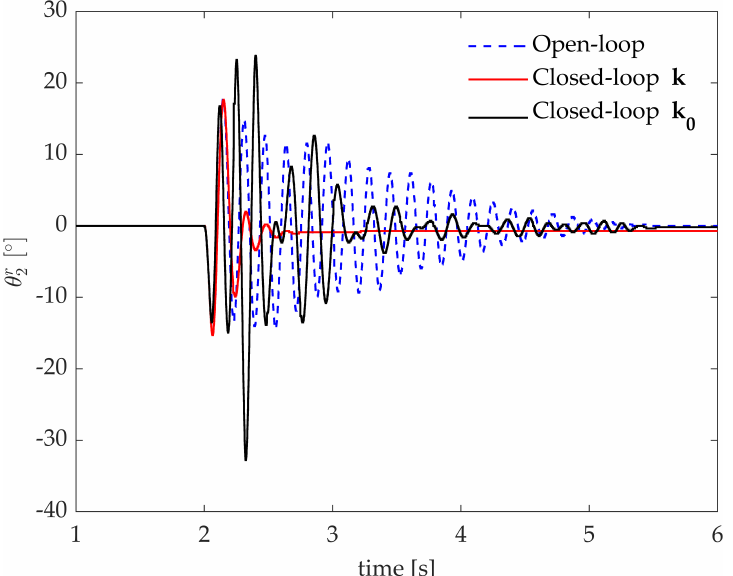
Figure 10. Test case 1: experimental impulse response with the non-robust controller k 0